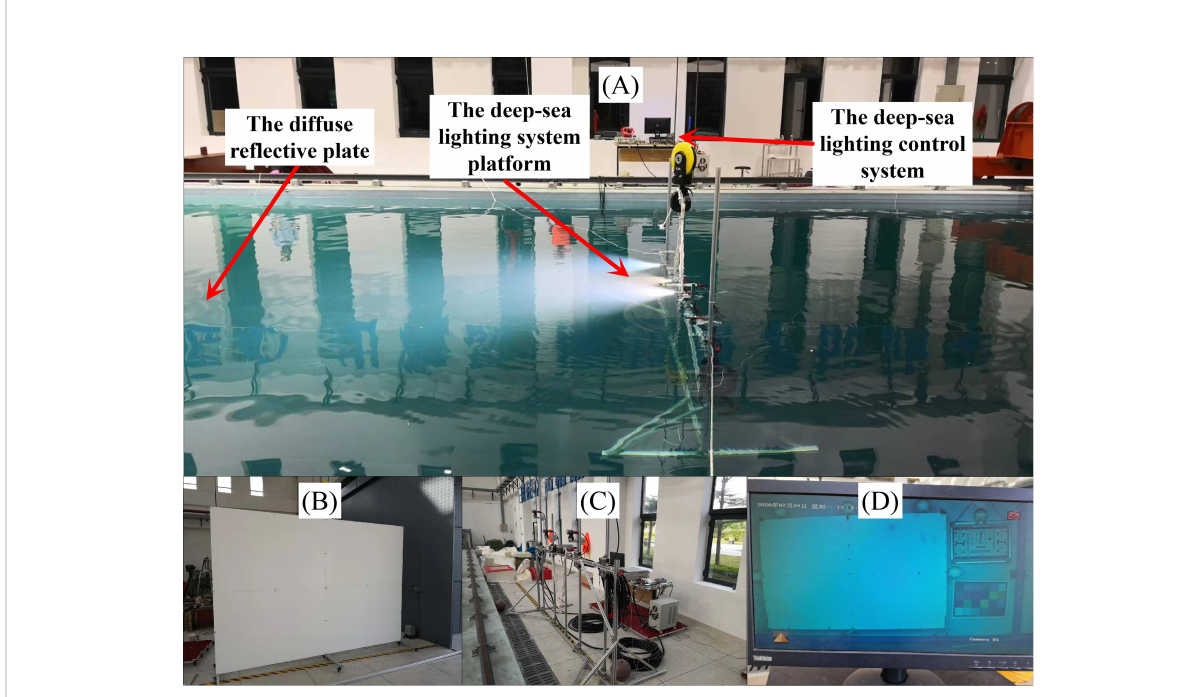
FIGURE 10 The experiment platform for deep-sea lighting system testing. (A) the experimental process; (B) the diffuse re fl ective plate with the size of 3.6m ×1.8m; (C) the deep-sea lighting system platform; (D) the captured experiment pictures.